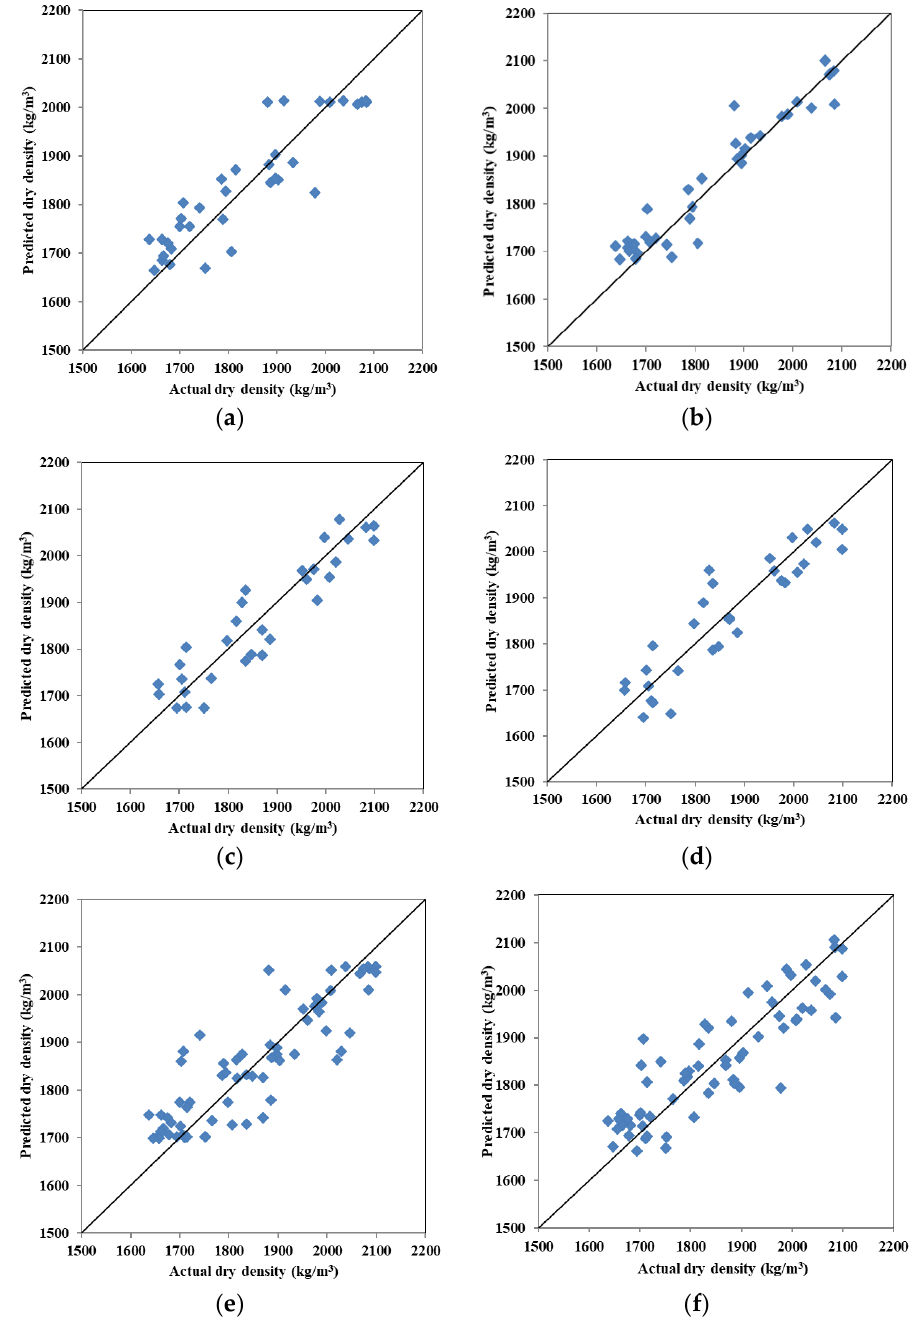
Figure 3. Graphical prediction accuracy of model for predicting dry density, ( a ) field, without velocity, ( b ) field, with velocity, ( c ) lab, without velocity, ( d ) lab, with velocity, ( e ) field plus lab, without velocity, ( f ) field plus lab, with velocity.